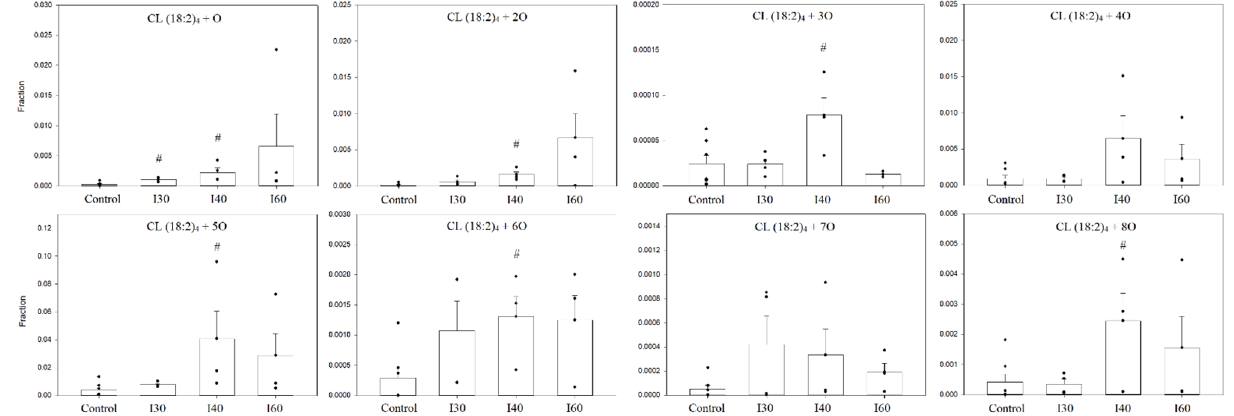
Figure 8. Relative amounts of oxidized cardiolipin species of control and ischemic kidney mitochon- dria. There was a significant increase of most oxidized cardiolipin species after 40 min ischemia. The relative quantification was computed by calculating the fraction of the integrated peak area by total peak are of all observed oxidized and non-oxidized tetralinoleoyl cardiolipin species. I 30—30-min ischemia, I40—40-min ischemia, I60—60-min ischemia; CL (18:2) 4 + number of additional oxygen atoms; n = 4–7; (# p < 0.05 control vs. ischemia, dots represent values of each experiment, mean ± standard error).